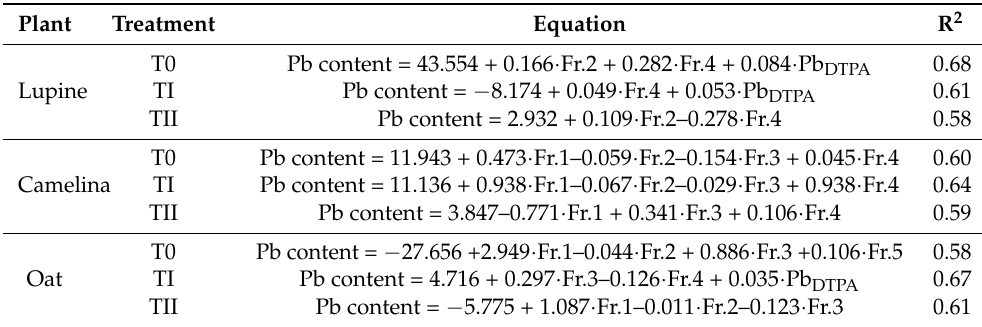
Table 6. Multiple regression equations for relations between Pb contents in plants and in Pb forms for soils with applied amendments.